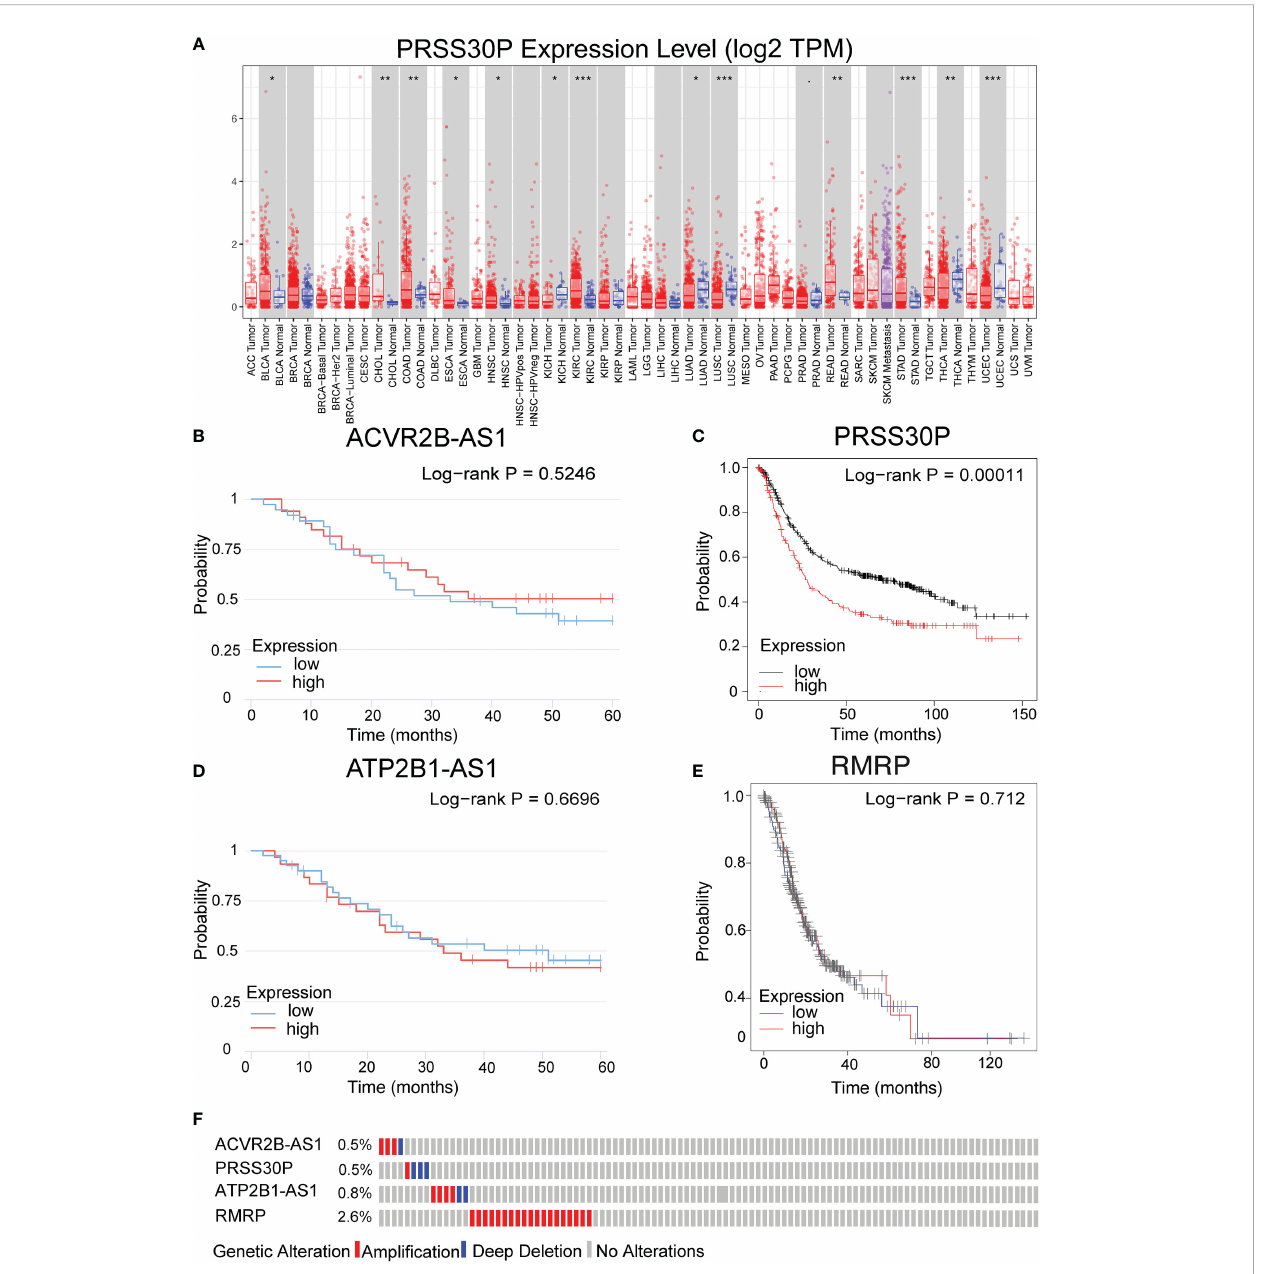
FIGURE 5 Expression and genetic alterations of the four predictive genes. (A) The expression level of PRSS30P in tumor tissue and normal tissue in TIMER (https:// cistrome.shinyapps.io/timer/). (B – E) Prognostic values of ACVR2B-AS1, PRSS30P, ATP2B1-AS1, and RMRP expression in overall survival. (F) Genetic alterations of the four genes. Data were from the cBioPortal for Cancer Genomics (http://www.cbioportal.org/). *P<0.05; **P<0.01; and